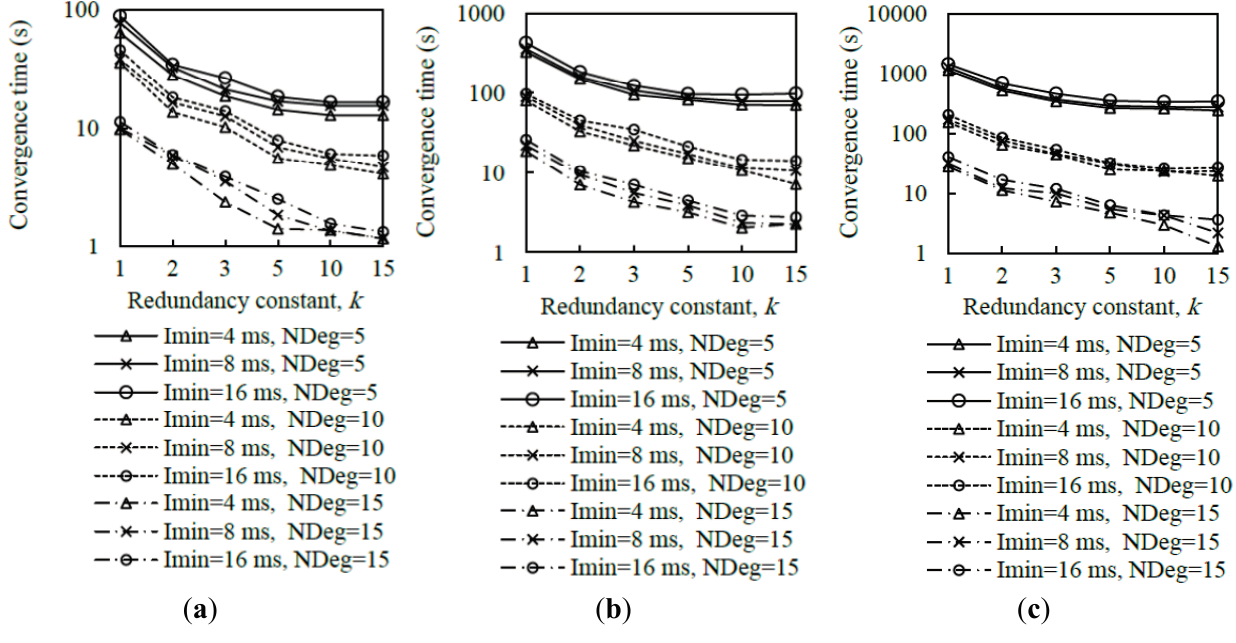
Figure 10. Influence of I on the network convergence time in the small, medium and min large network scenarios with different average node degrees as a function of the redundancy constant, k , when the I value is set to 4 ms, 8 ms and 16 ms. ( a ) Small, min ( b ) medium, and ( c ) large network size scenarios.